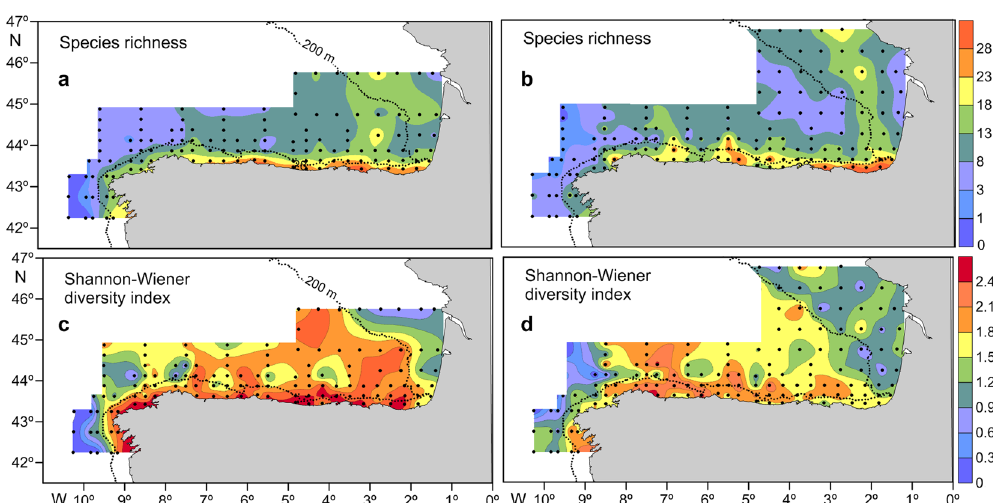
Figure 5. Horizontal distribution of: ( a ) Species richness during the CAREVA cruise (CC); ( b ) species richness during the JUREVA cruise (JC); ( c ) Shannon-Wiener diversity index during the CC; ( d ) Shannon-Wiener diversity index during the